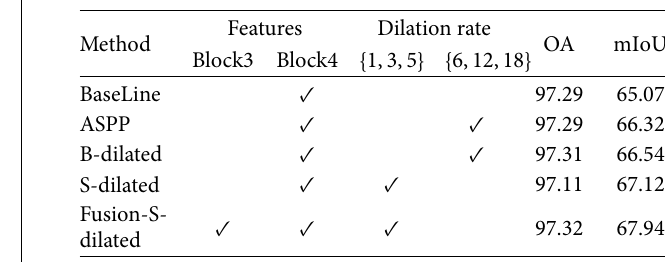
Figure 6: The results of crack detection on (a) CFD and (b) AigleRN datasets. Table 4: Comparisons of the results with different feature maps and dilation rates in the multiscale dilated convolution